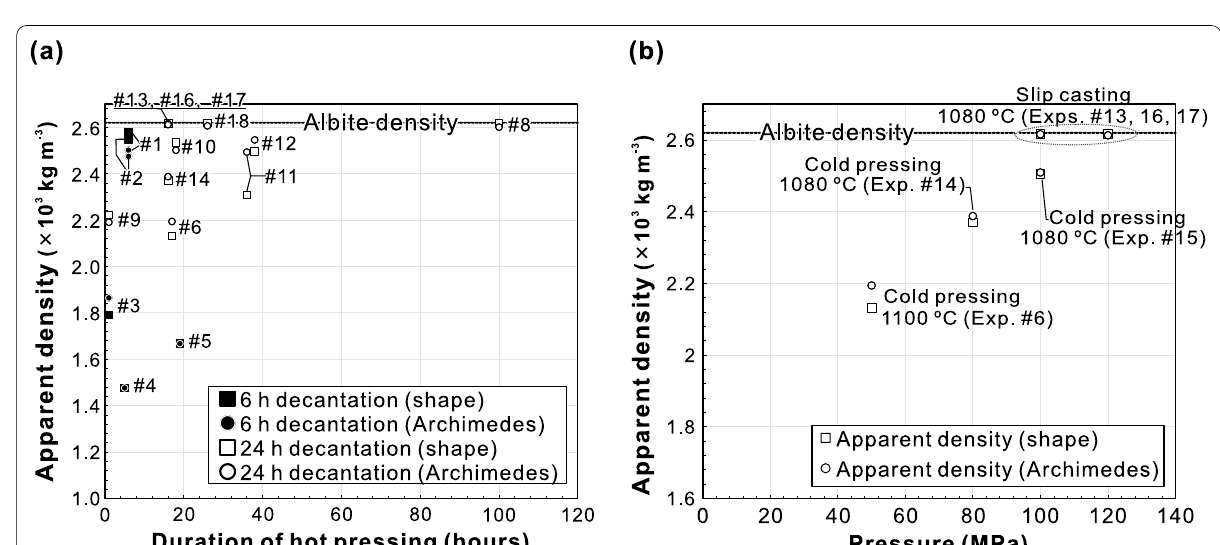
Fig. 5 Apparent density of the samples after hot pressing. Data are also shown in Tables 1, 3. a Relationship between the apparent density and duration of hot pressing. The experimental numbers are annotated on the figure. See Table 1 for the experimental conditions. b Relationship between the apparent density and pressure. The experimental numbers, temperatures and forming methods are annotated on the